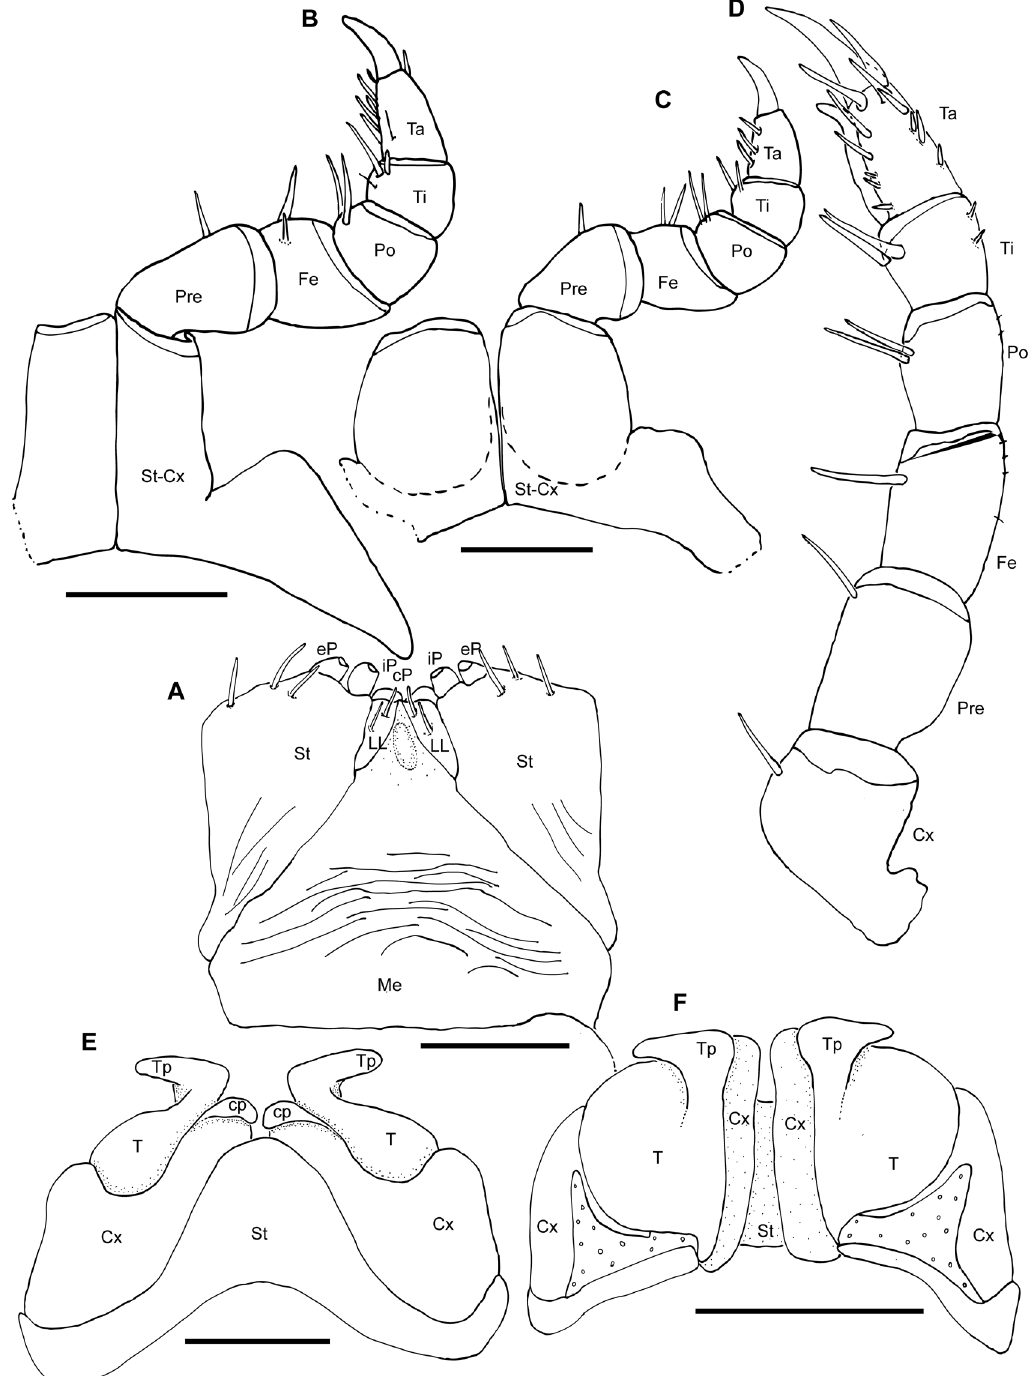
Fig. 4. Dichromatobolus elephantulus gen. et sp. nov., holotype, ♂ (CAS MG-54C-78), drawings. A . Gnathochilarium, ventral view. B . Second leg pair, posterior view. C . First leg pair, posterior view. D . Left midbody leg pair, posterior view. E . Anterior gonopod, anterior view. F . Anterior gonopod, posterior view. Abbreviations: cp = coxite process; cP = central pads; Cx = coxite; eP = lateral palpus; Fe = femur; iP = inner palpus; LL = lamellae lingualis; Me = mentum; Po = postfemur; Pre = prefemur; St = sternite; St-Cx = sterno-coxite; T = telopodite; Ta = tarsus; Ti = tibia; Tp = telopodite process. Scale bars = 1